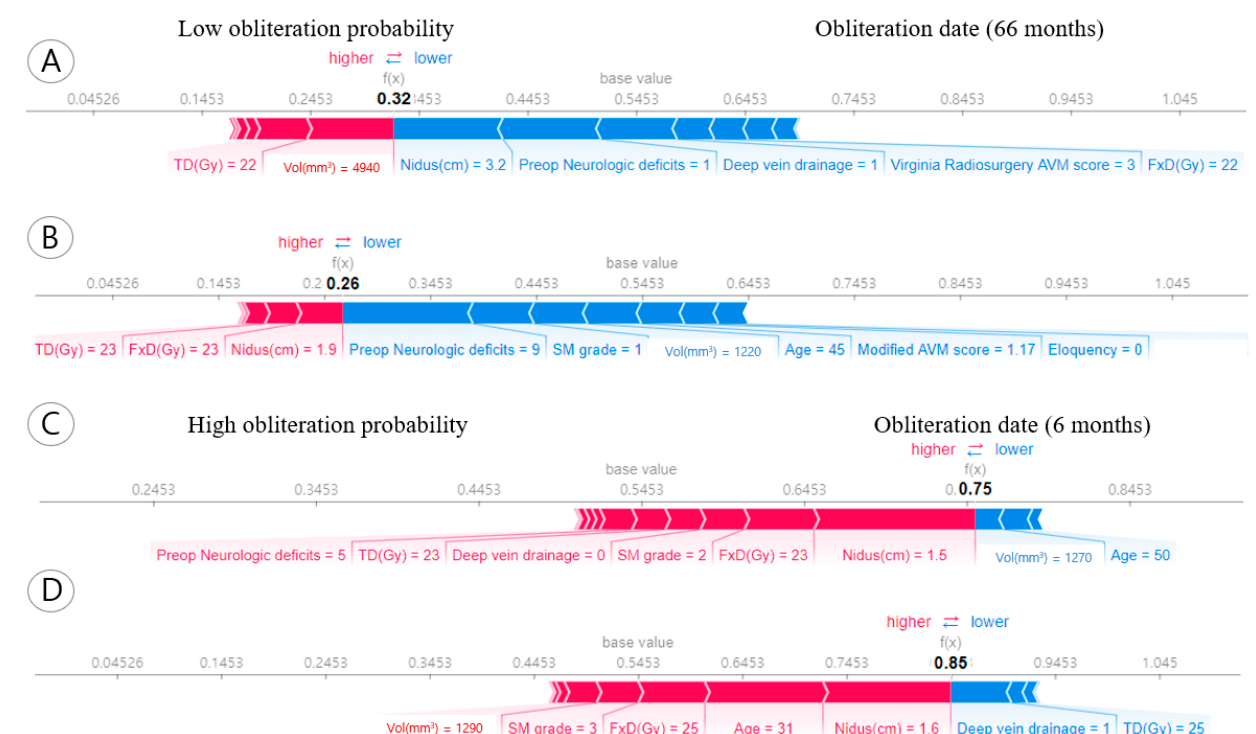
Figure 4. Nidus obliteration probability with the related clinical and dosimetric features for each patient. ( A ) For patient A, who underwent AVM radiosurgery in our institution, the nidus volume was 4940 mm 3 , the nidus size was 3.2 cm, and the obliteration timepoint was 66 months (SHAP value: 0.32), with a low probability of a delay in curing AVM). ( B ) In the case of B, in which the delayed nidus obliteration was more than 60 months, the SHAP score was 0.26. ( C ) In case C, the nidus size was 1.5 cm (small), the Spetzler–Martin grade was 2, and the obliteration timepoint was 6 months (0.75, with a high probability for nidus obliteration). ( D ) Patient D showed high obliteration probability in nidus size (1.6 cm).